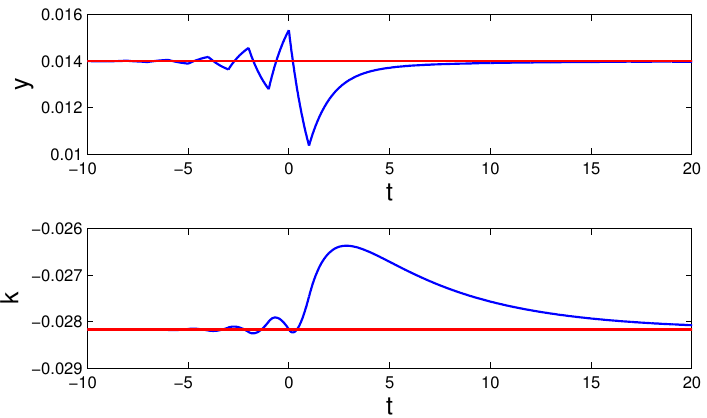
Fig. 2 The homoclinic solution of (9). The bounded solutions φ c ( t ) and φ d ∗ ( t ) are depicted in blue and red colors, respectively. It seen in the figure that φ c ( t ) is homoclinic to φ d ∗ ( t ) .